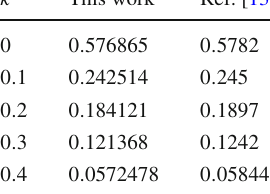
Table 3 Cross-check the results of the decay widths in this work with